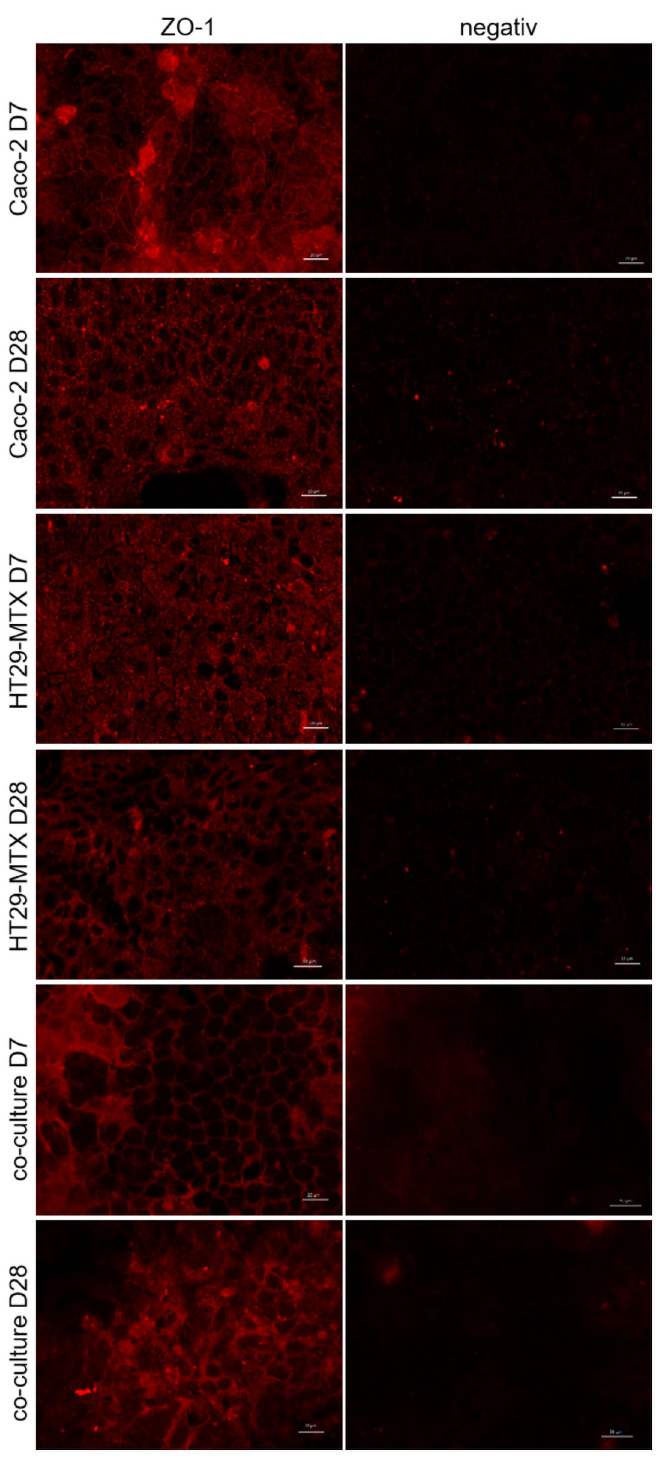
Fig 3. Immunofluorescence staining (top view) of ZO-1 in Caco-2, HT29-MTX and co-cultured Caco-2 and HT29-MTX cells cultivated for 7 (D7) and 28 days (D28). ZO-1 is displayed in red. Representative figures are shown, chosen from three independent experiments with three technical replicates per cellular